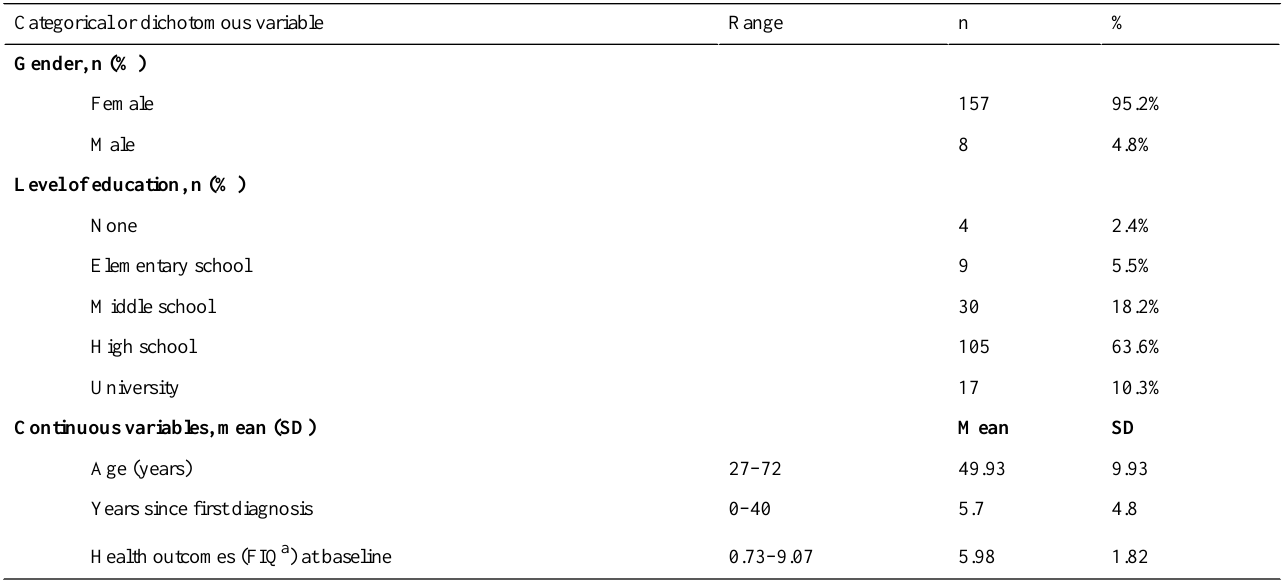
Table 1. Descriptive sample characteristics.